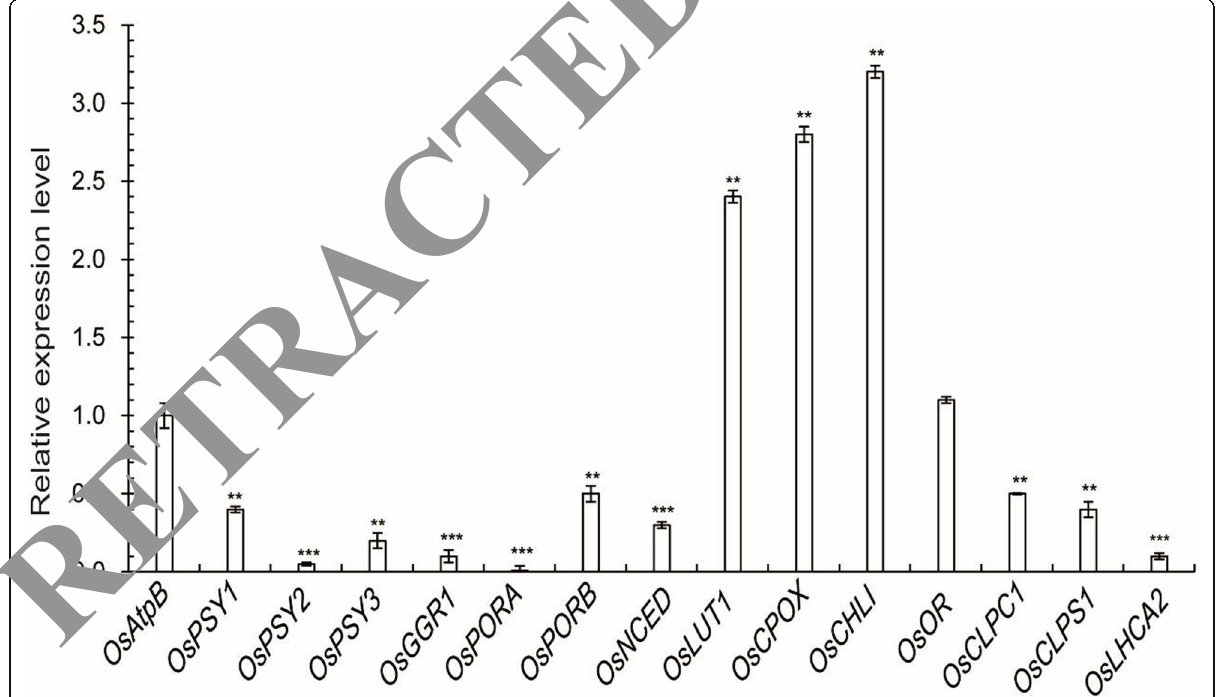
Fig. 6 Expression analysis of genes in carotenoid biosynthesis and validation of genes identified in RNA-seq analysis. qRT-PCR analysis of genes related to carotenoid biosynthesis, chlorophyll biosynthesis and validation of genes identified as DEGs in oslil3 vs WT this transcriptome analysis. Two reference genes were used as internal controls. The expression levels of genes in WT plants were set to 1. OsAtpB , Os10g21266; OsPSY1 , Os06g51290; OsPSY2 , Os12g43130; OsPSY3 , Os09g38320; OsGGR , Os02g51080; OsPORA , Os04g58200; OsPORB , Os10g35370; OsNECD , Os12g24800; OsLUT1 , Os10g39930; OsCPOX , Os04g52130; OsCHLI , Os03g36540; OsOR , Os02g43500; OsCLPC1 , Os04g32560; OsCLPS1 , Os08g33540; OsLHCA2,